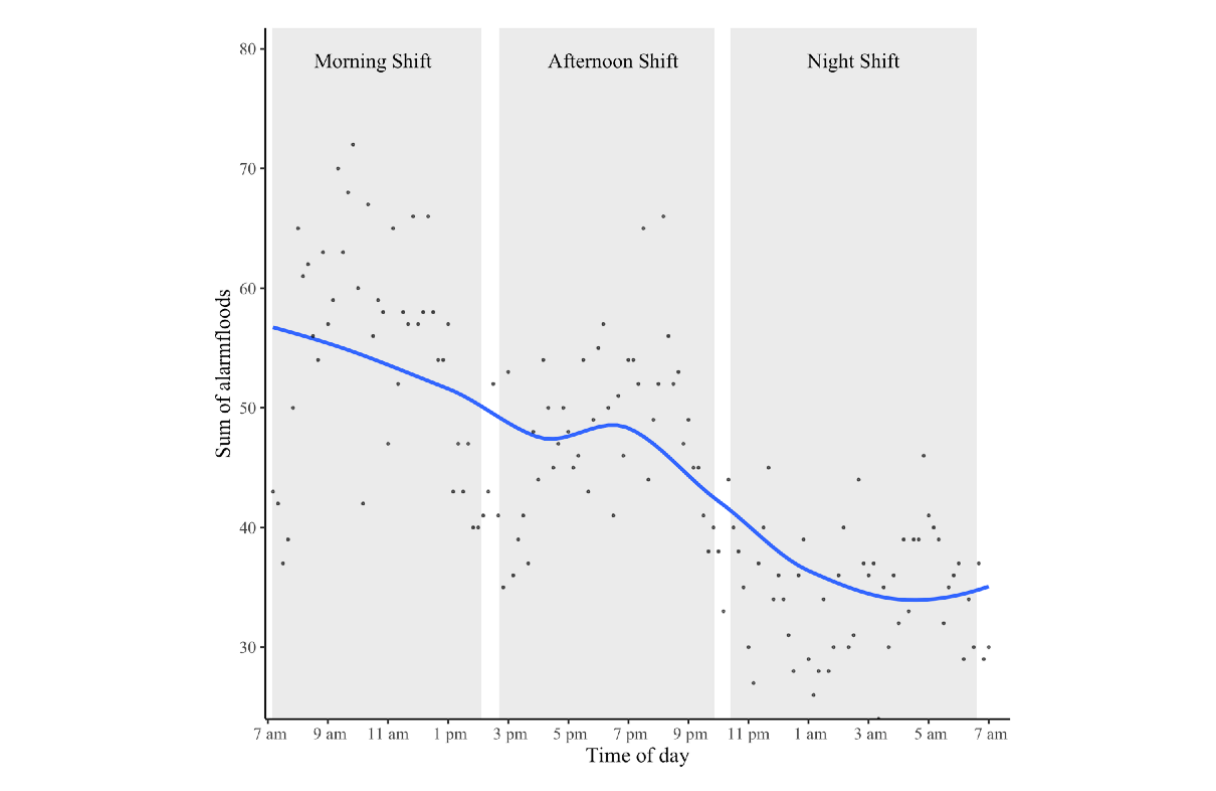
Figure 5. Temporal distribution of alarm flood conditions over 24 hours. Each dot indicates the sum of all alarm flood conditions that were initiated at the respective time of day in 10-minute intervals. For example, the first dot on the far left indicates that 43 alarm floods occurred between 7:10 and 7:20 AM across all days in the data. The blue line is a local regression, calculated by ggplot2’s smoothing function (formula: y ~ x). The white spaces between the grey bars (ie, shifts) visualize handover